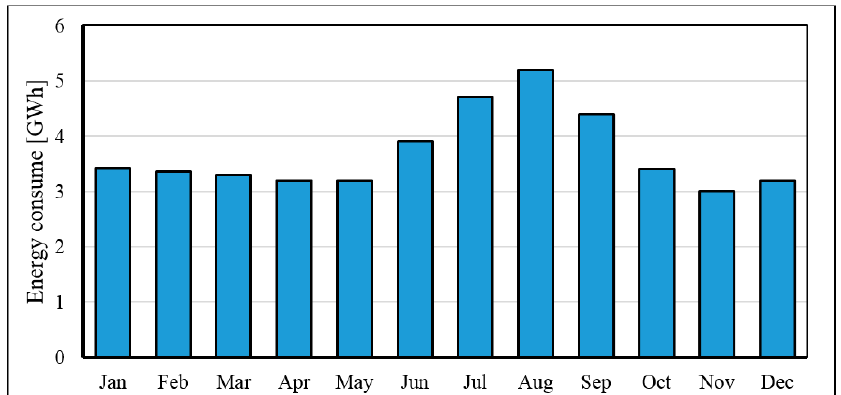
Figure 2. Monthly electrical energy consumption in 2008 [16].